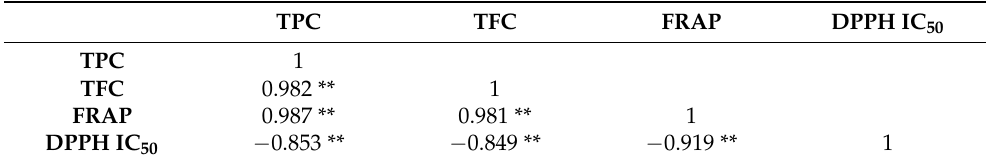
Table 3. Pearson’s correlation matrix of all values of total phenolic content (TPC), total flavonoid content (TFC), FRAP values, and the IC 50 DPPH. TPC TFC FRAP DPPH IC 50 TPC 1 TFC 0.982 ** 1 FRAP 0.987 ** 0.981 ** 1 DPPH IC 50 − 0.853 ** − 0.849 ** − 0.919